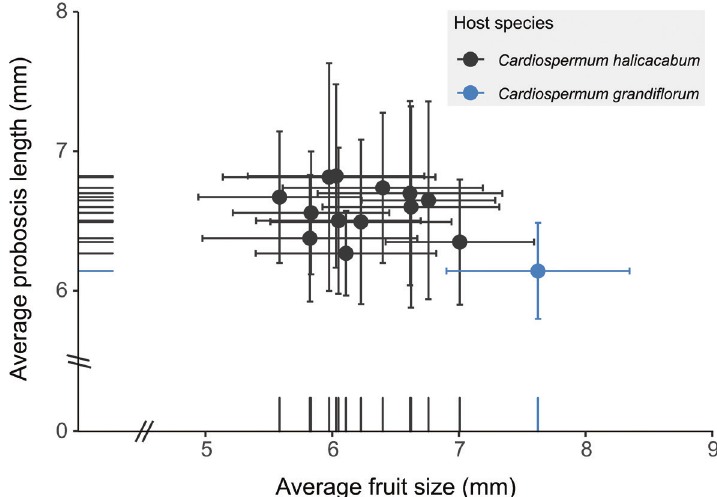
Figure 5. Relationship between proboscis length and fruit size (distance from balloon exterior to nearest seed coat) for soapberry bugs and their associated balloon vine host species in Kruger National Park. Each point represents a single population and error bars are ±